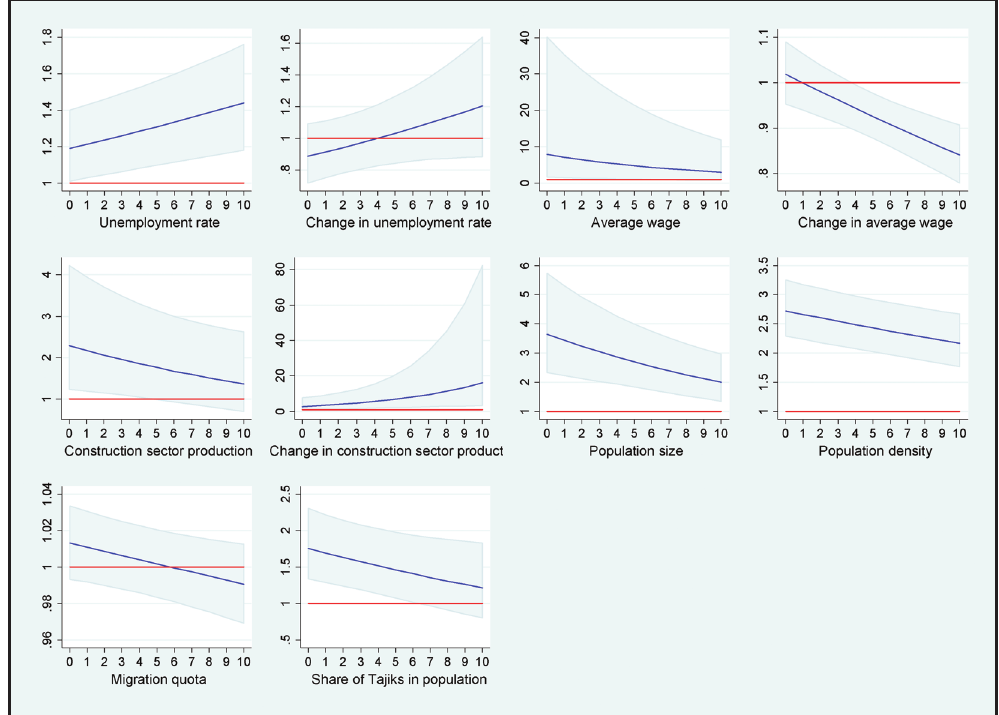
Odds ratios of regional variables with number of years abroad. Note: 95% confi- dence intervals